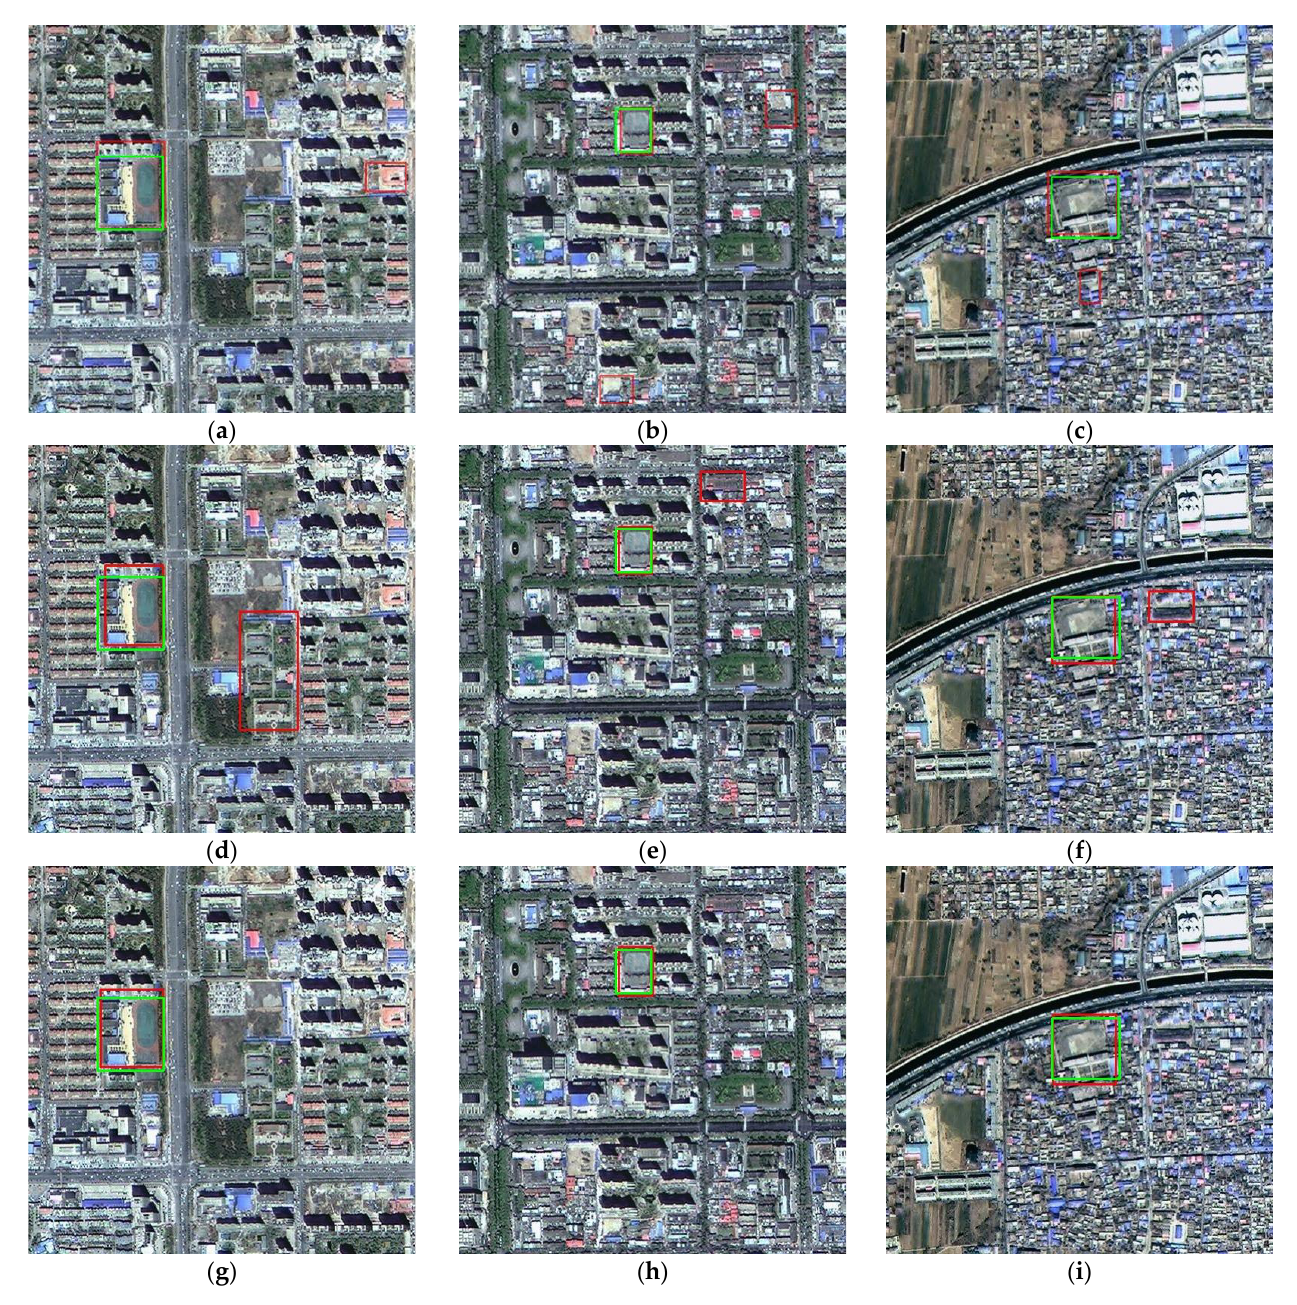
Figure 8. Results of different methods on the test set: ( a – c ) are the detection results of the FPN detector, ( d – f ) are the detection results of FCOS, and ( g – i ) are the detection results of our proposed method. The ground truth boxes are plotted in green, and the detection results of the proposed method are plotted in red.